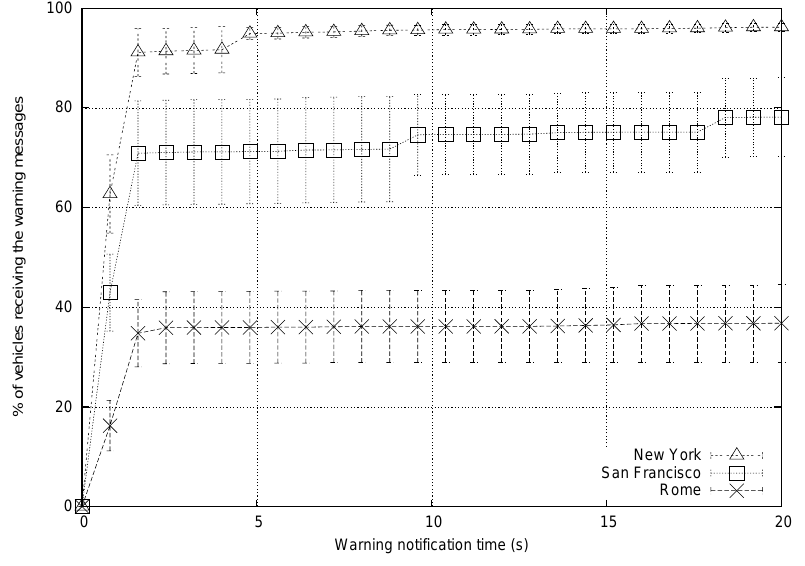
Figure 7. Warning notification time when varying the roadmap.